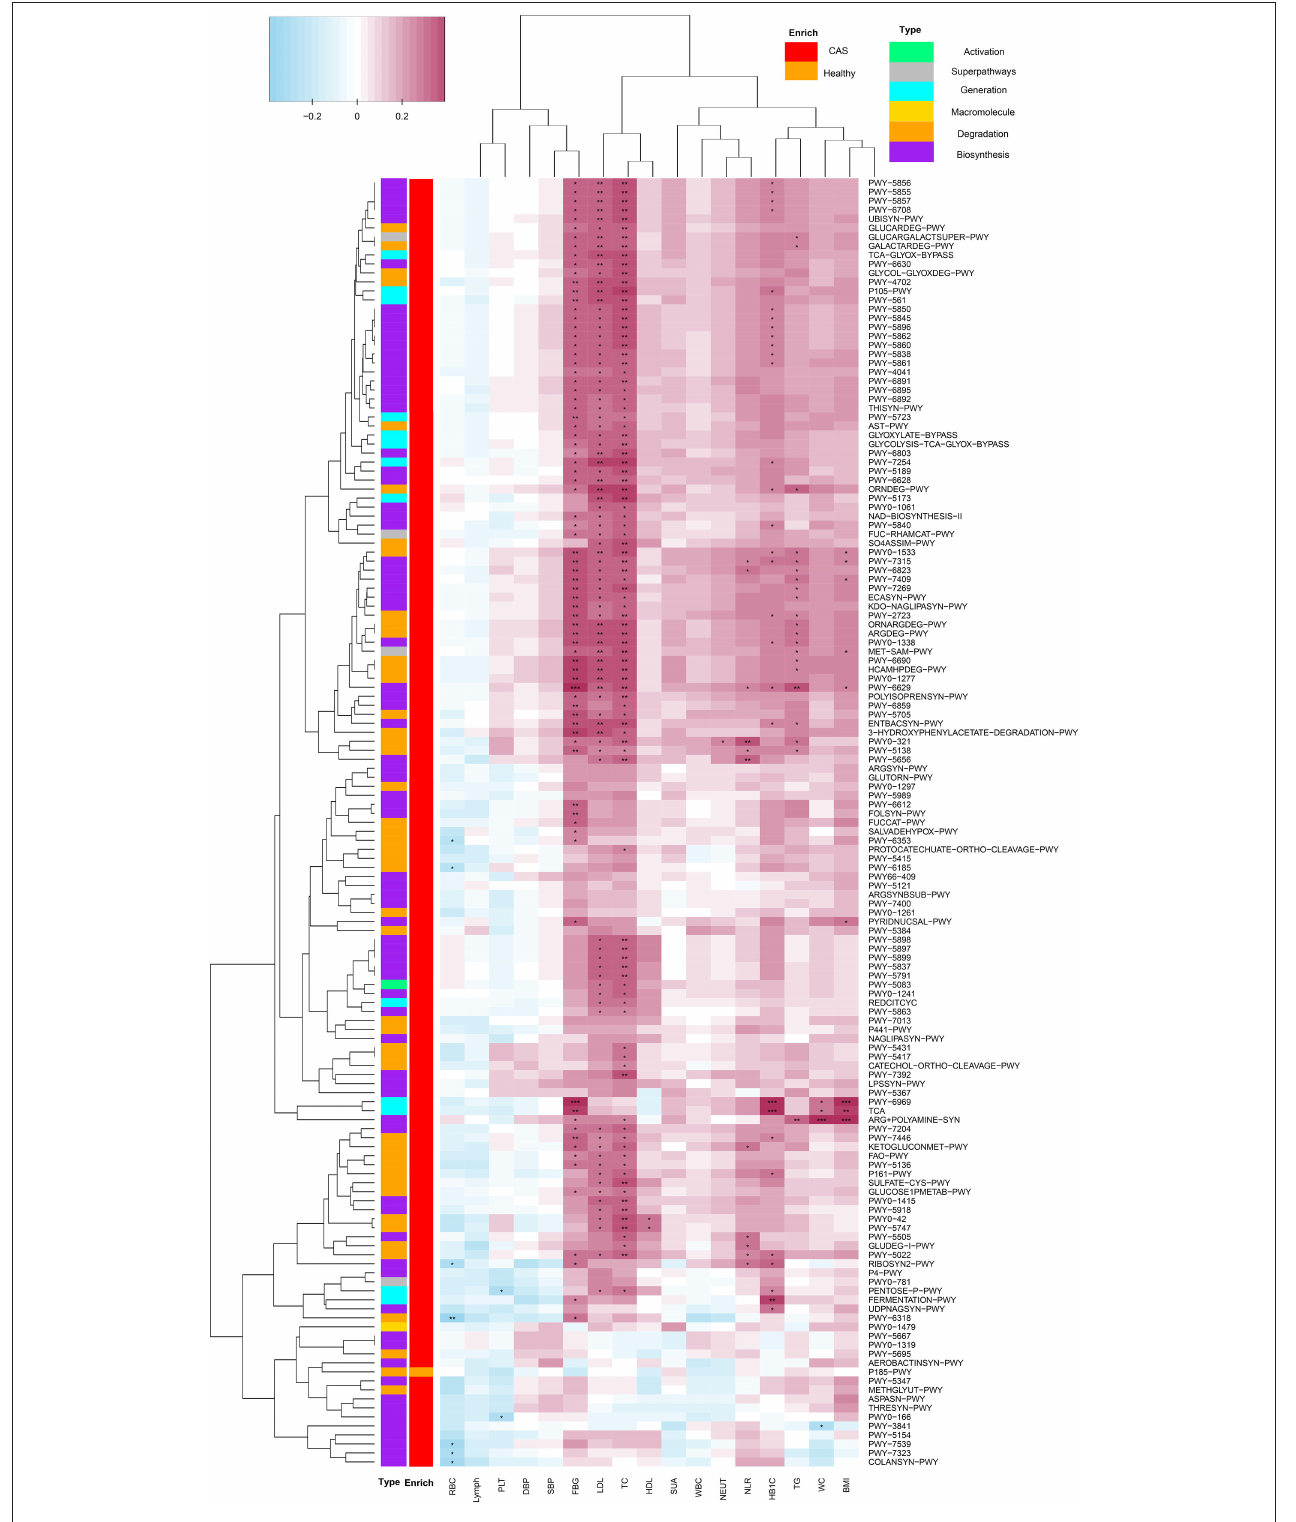
FIGURE 5 | Spearman’s correlation matrix for carotid arteriosclerosis-associated pathways and clinical characteristics. Cell color indicates the correlation type (pink: positive, blue: negative). *, **, and ***denote p < 0.05, p < 0.01, and p < 0.001, respectively.